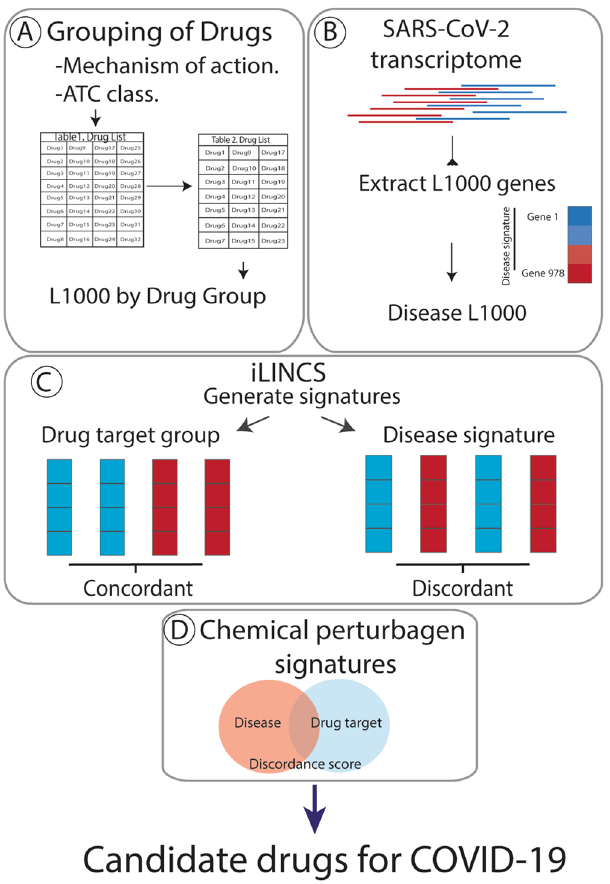
Figure 1. Overview of the workflow to identify candidate repurposable drugs to combat COVID-19. ( A ) Drugs that are currently in use to treat coronavirus and putative COVID-19 treatments were clustered based on mechanism of action and ATC class. ( B ) Gene expression data of the 978 genes that comprise the Library of Integrated Network-Based Cellular Signature (iLINCS) L1000 genes were extracted from severe acute respiratory syndrome coronavirus 2020 (SARS-CoV-2) (GSE147507) transcriptomic datasets. ( C ) Consensus iLINCS gene signatures were generated for drug groupings and disease. ( D ) Connectivity analysis was conducted and a list of chemical perturbagens that are concordant (≥ 0.321 concordance) to the drug target grouping signatures or discordant (≤ − 0.321 discordance) to the disease signatures was generated. Chemical perturbagens are filtered and curated to identify top candidate repurposable drugs.